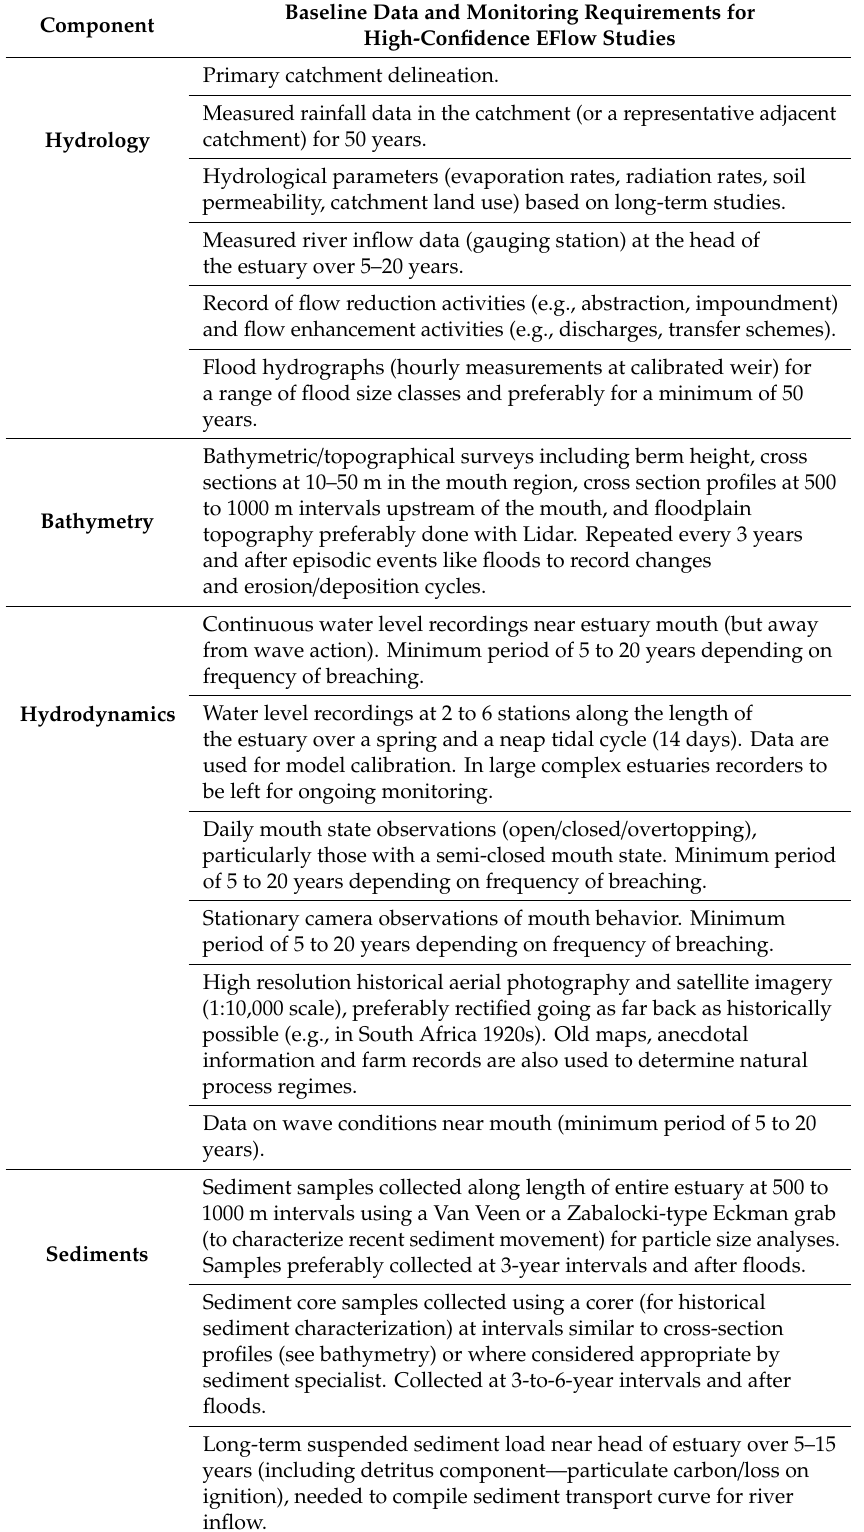
Table 5. Data and monitoring pre-requisites for EFlow studies (modified from Taljaard et al. 2003, [97]).